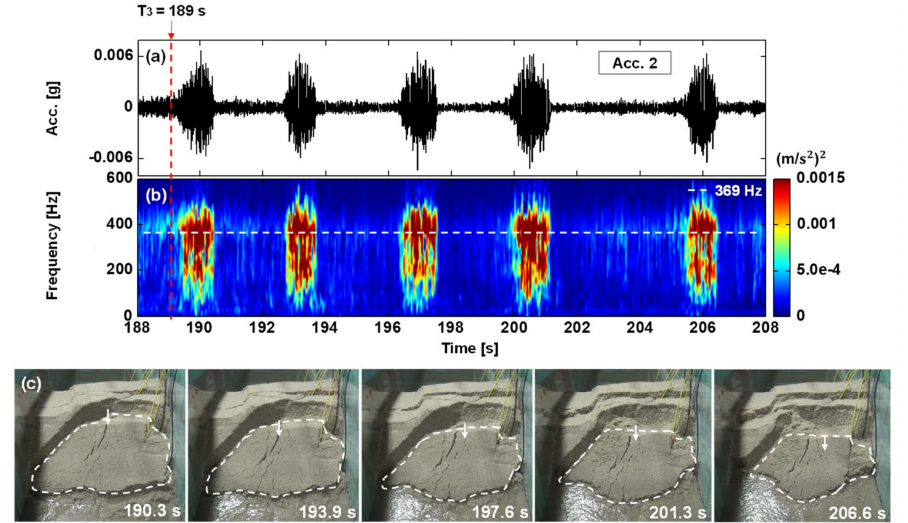
Figure 9. Event 4, the intermittent slide: ( a ) seismic signal, ( b ) time–frequency spectrum, ( c ) series of front views the intermittent